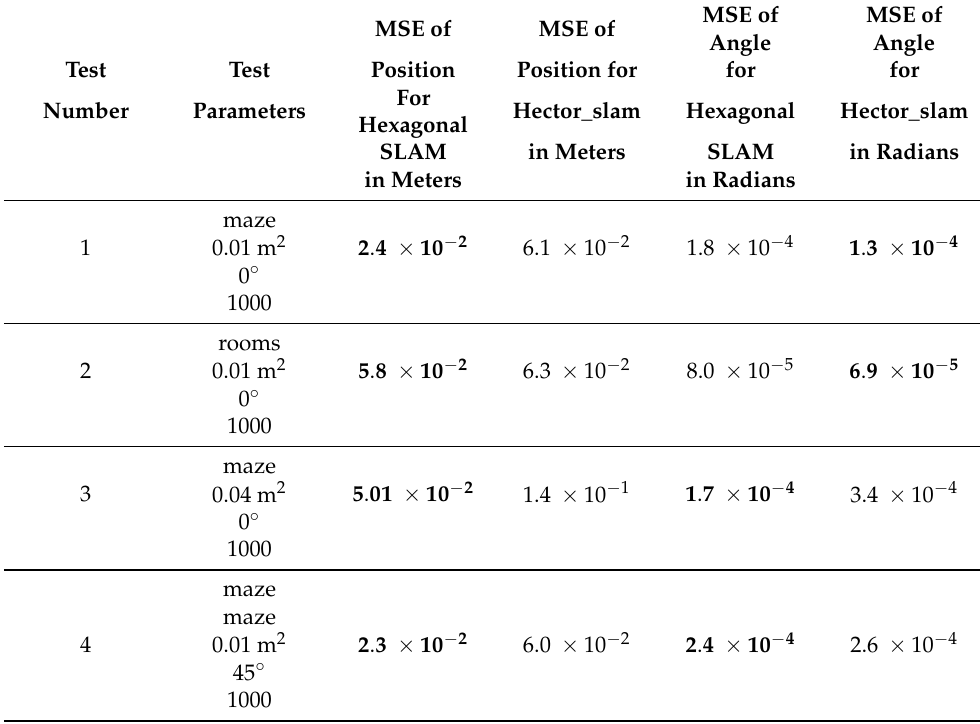
Table 1. Localization error for Hexagonal SLAM and hector_slam for various situations. Test Test Position Position for for for Number Parameters